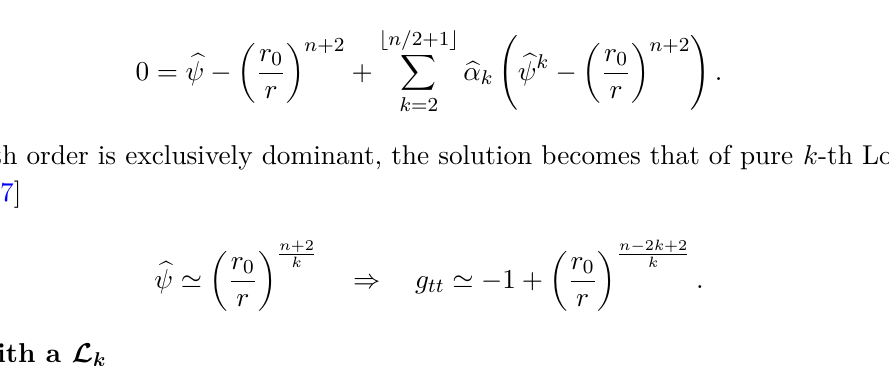
Figure 7 . Separate regions in the Einstein-Lovelock black hole with a correction L k for where ψ ( r ) = r − 2 , and r = r is the horizon radius. With the normalized metric 0 0 0